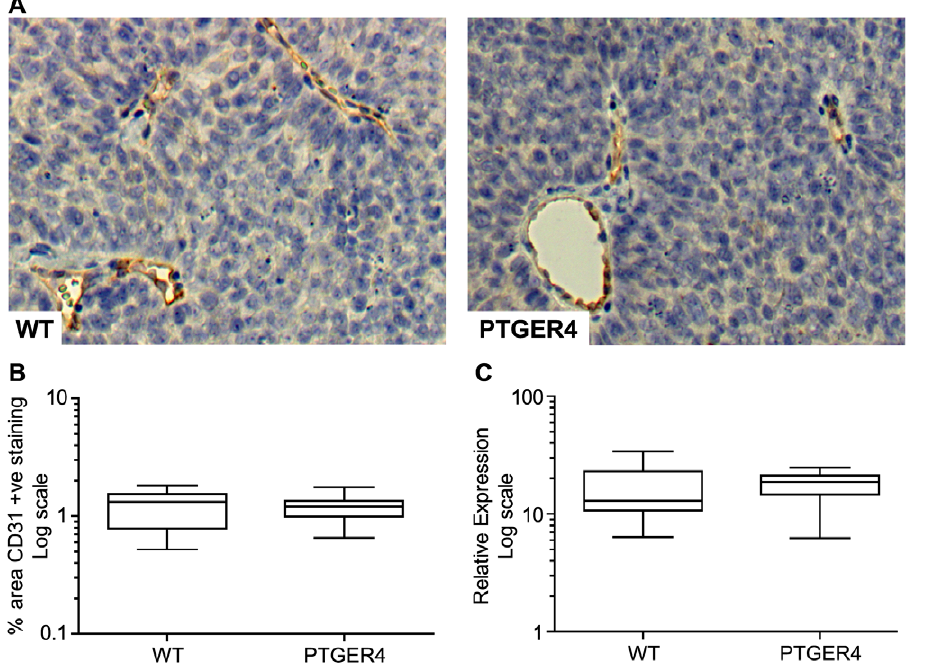
Figure 3. Differential tumour growth between WT and PTGER4 xenograft tumours is not due to enhanced angiogenesis. ( A ) Detection of blood vessels in WT (n=11 sections) and PTGER4 (n=11 sections) xenograft tumours as determined by immuno-staining with the endothelial cell marker CD31. ( B ) Quantitative stereology of blood vessel density in WT and PTGER4 xenograft tumours as determined by percentage area positively stained for CD31. ( C ) mRNA expression of the angiogenic factor VEGF in WT (n=10) and PTGER4 (n=10) xenograft tumours.